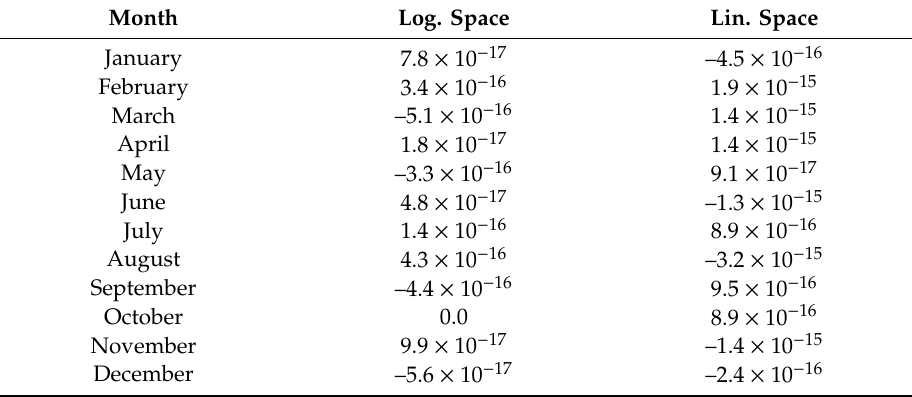
Table A3. Mean values of residuals for each month and regression scheme.